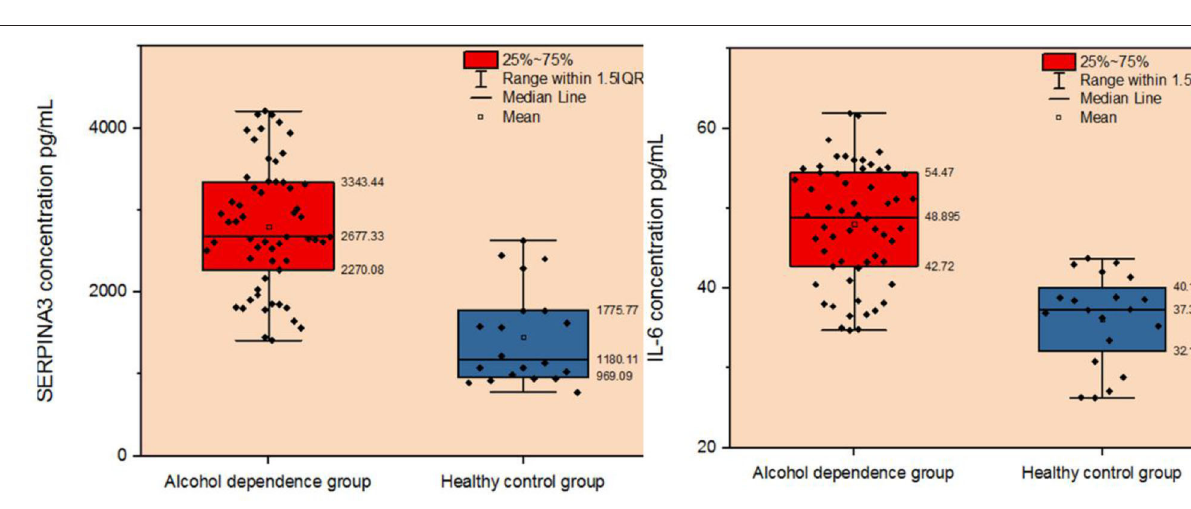
miRNAs obtained from the five databases, was taken as the prediction result of the target genes ( Figure 4